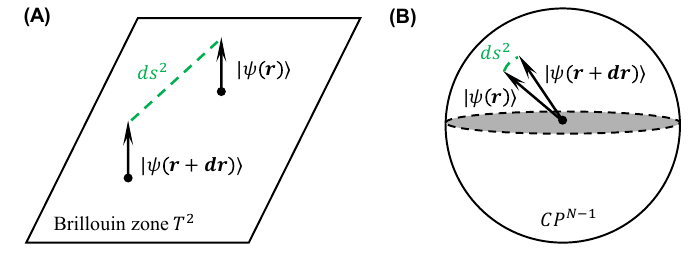
Figure 1. Illustration of the distance between two nearby quantum states in the parametric space. ( A ) The geometric picture of quantum distance in Brillouin zone T 2 . ( B ) The geometric picture of quantum distance on Bloch